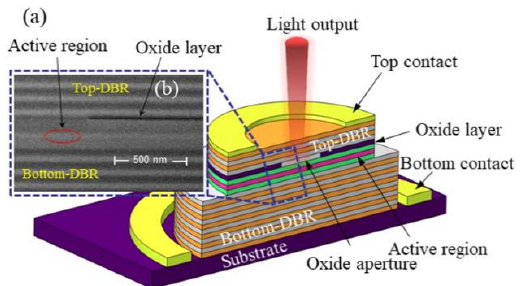
Figure 1. The image of high speed 850 nm VCSEL. ( a ) Schematic diagram and ( b ) FIB-SEM image in cross section of the active region.